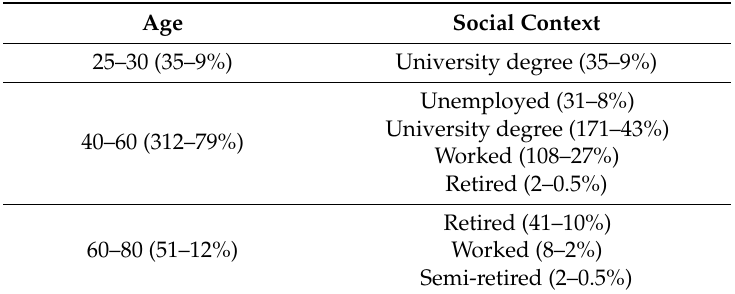
Table 2. Age and social context of included